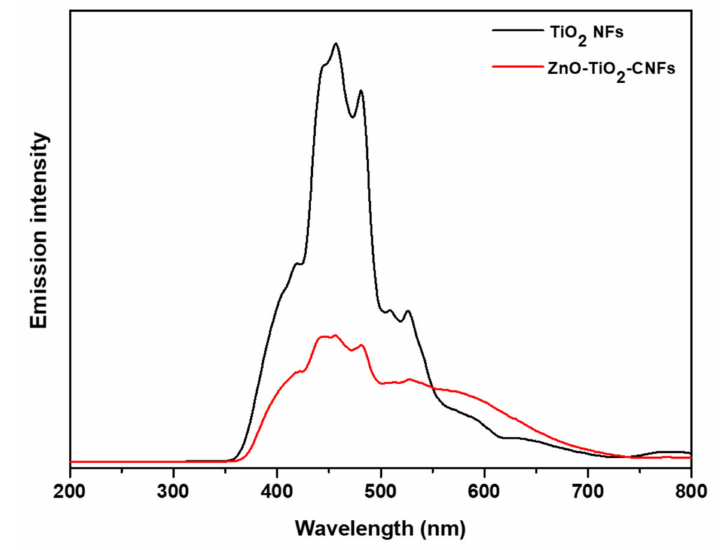
Figure 7. Photoluminescence (PL) spectra of ZnO-TiO 2 -CNFs composite as compared to the pristine TiO 2